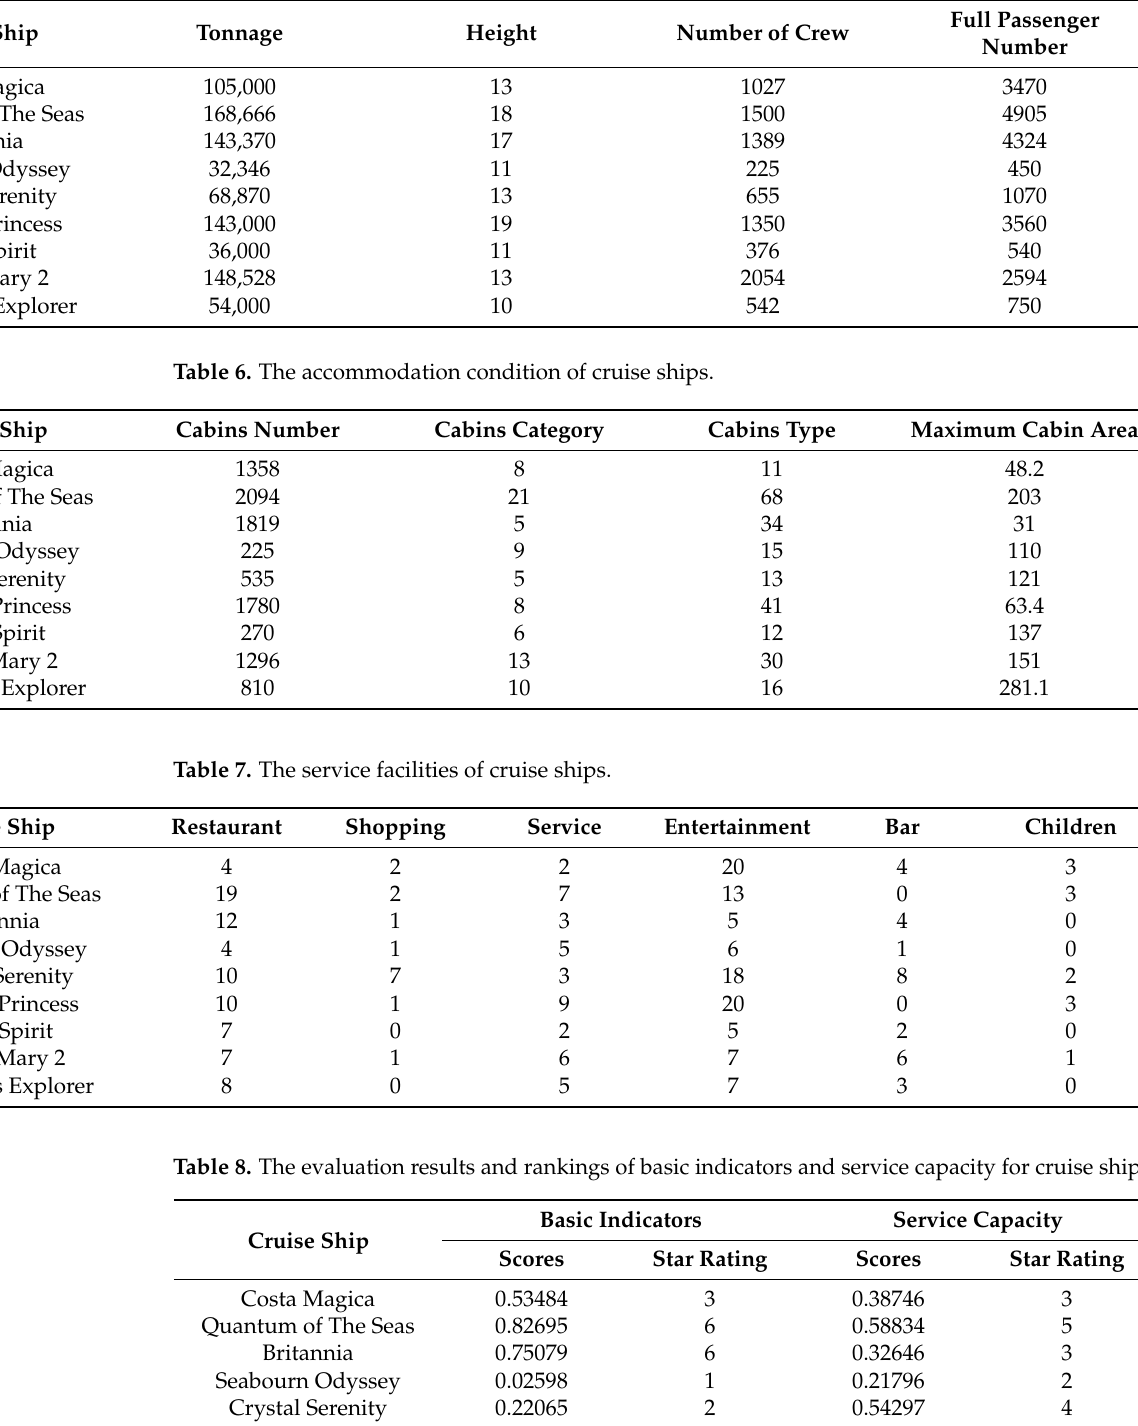
Table 5. The basic indicators of cruise ships.